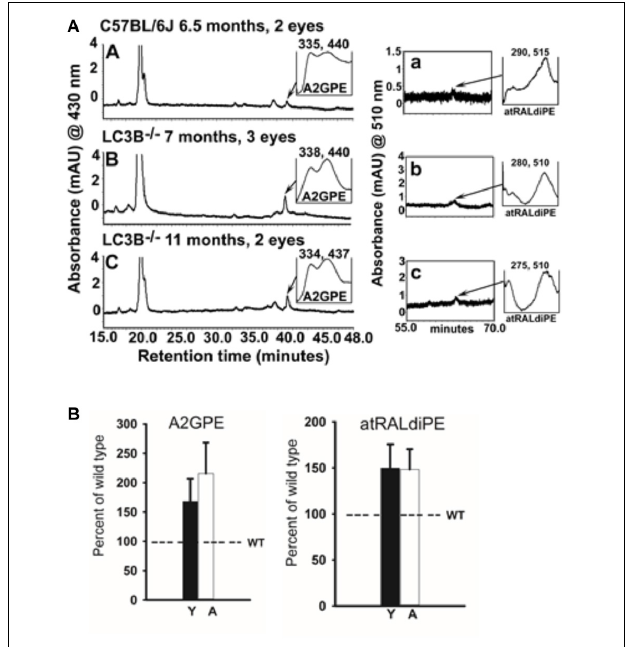
FIGURE 9 | (A) Bisretinoid accumulate in the LC3B − / − mouse. Left, representative chromatogram at 15–48 min retention time (monitored at 430 nm) for WT (6.5 months) and LC3B − / − (7 and 11 months old) mice showing UV visible absorption spectrum of A2GPE; Right, chromatograms at 55–70 min retention time with monitored at 510 nm showing absorbance spectrum of atRALdiPE. mAU , milli-absorbance unit. (B) Quantification of the lipofuscin pigments A2GPE ( left ) and atRALdiPE ( right ) in the eyes WT (6.5 months) and LC3B − / − (7 and 11 months). Levels were determined as integrated peak areas normalized to synthesized external standards. Values (mean ± SE) are expressed as percentage of WT; Y (young), A